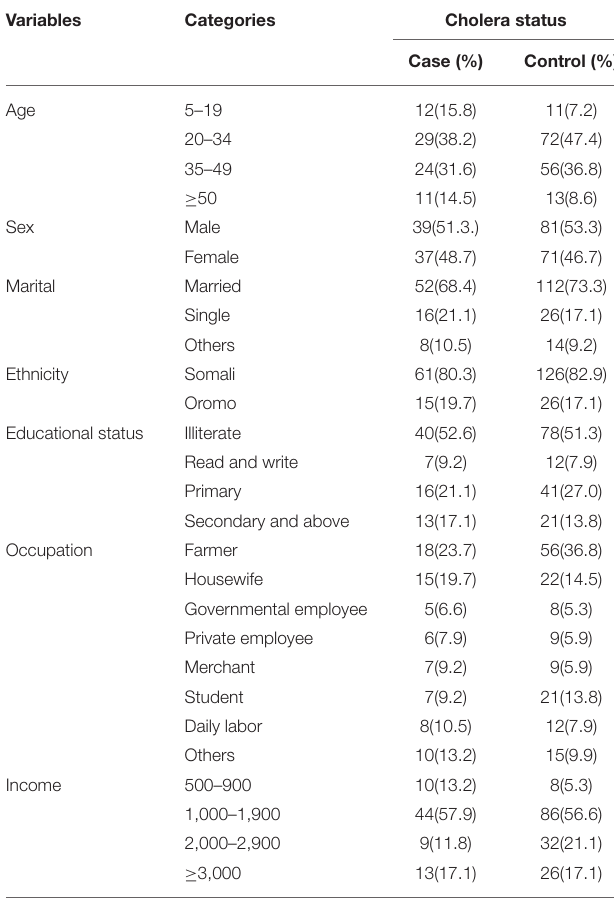
TABLE 1 | Socio-demographic characteristics of study population,